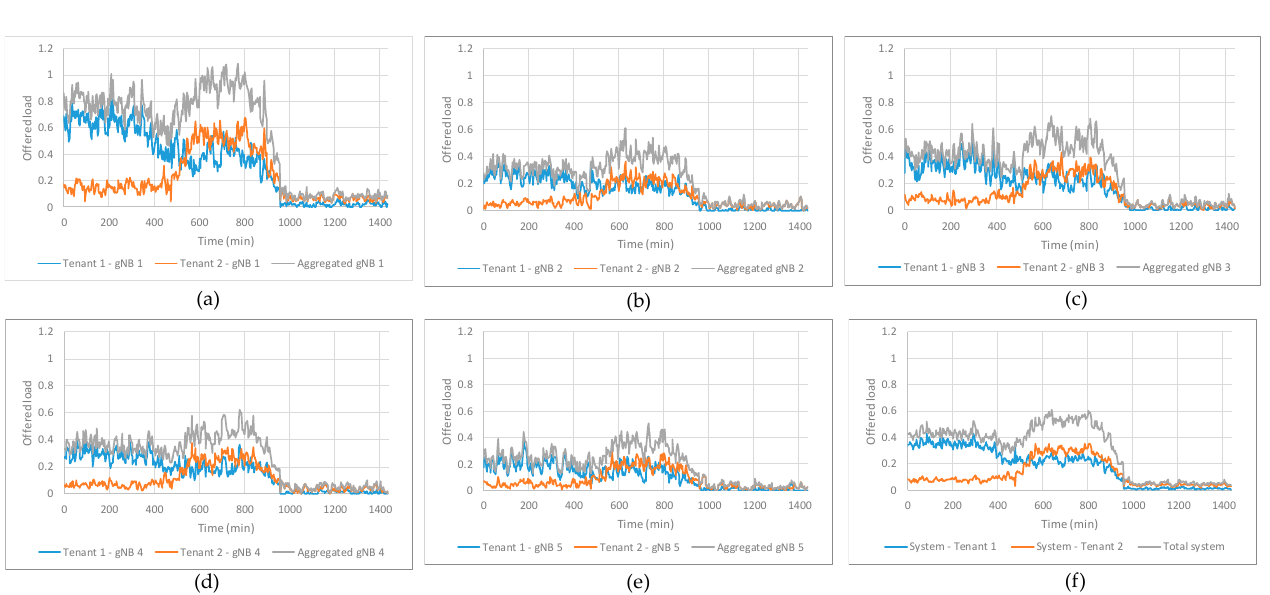
Figure 4. Offered loads per tenant and aggregated for ( a ) gNB 1, ( b ) gNB 2, ( c ) gNB 3, ( d ) gNB 4, ( e ) gNB 5 and ( f ) at system level.